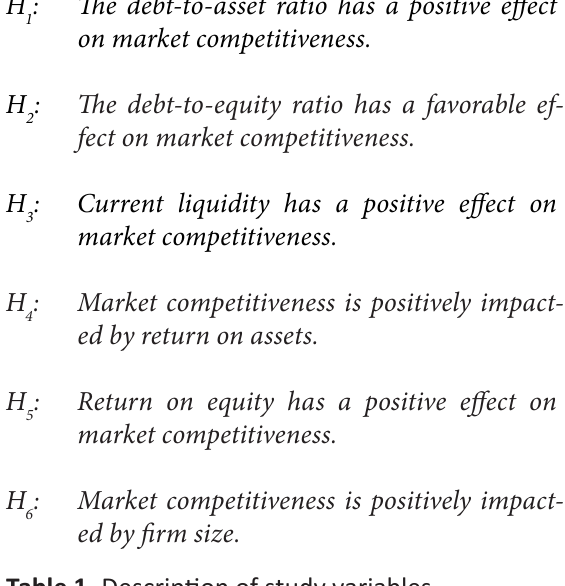
Table 1. Description of study